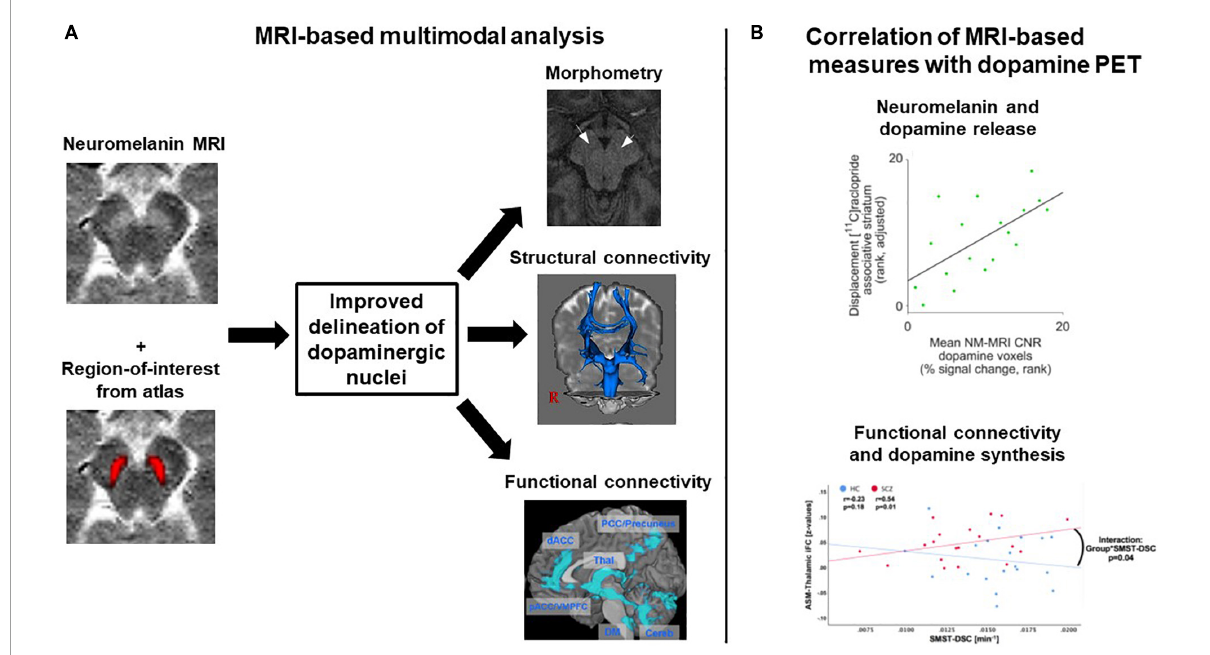
FIGURE6 Exemplary concepts for multimodal analyses involving several dopamine MRI methods or combining MRI and dopamine PET. (A) MRI-based multimodal analysis. A combination of neuromelanin MRI data, which have a high contrast for dopaminergic midbrain nuclei, and regions-of-interest from atlases, which for example were constructed based on structural MRI data, might improve the delineation of dopaminergic nuclei. The regions-of-interest derived from such a delineation procedure could then, in a second step, be used for morphometric analyses or as seed regions for structural and functional connectivity analyses. Plots adapted with permission from (171) and (107). (B) Multimodal combination of MRI and dopamine PET data. Two examples from the literature are shown, displaying correlation analyses between MRI measures and dopamine PET measures. Plots adapted under Creative Commons license or re-use of own work in line with journal guidelines from (43) and (172). ASM, auditory-sensorimotor network; HC, healthy controls; iFC, intrinsic functional connectivity; NM-MRI CNR, neuromelanin MRI contrast-to-noise-ratio; SCZ, patients with schizophrenia; SMST-DSC, sensorimotor striatum dopamine synthesis